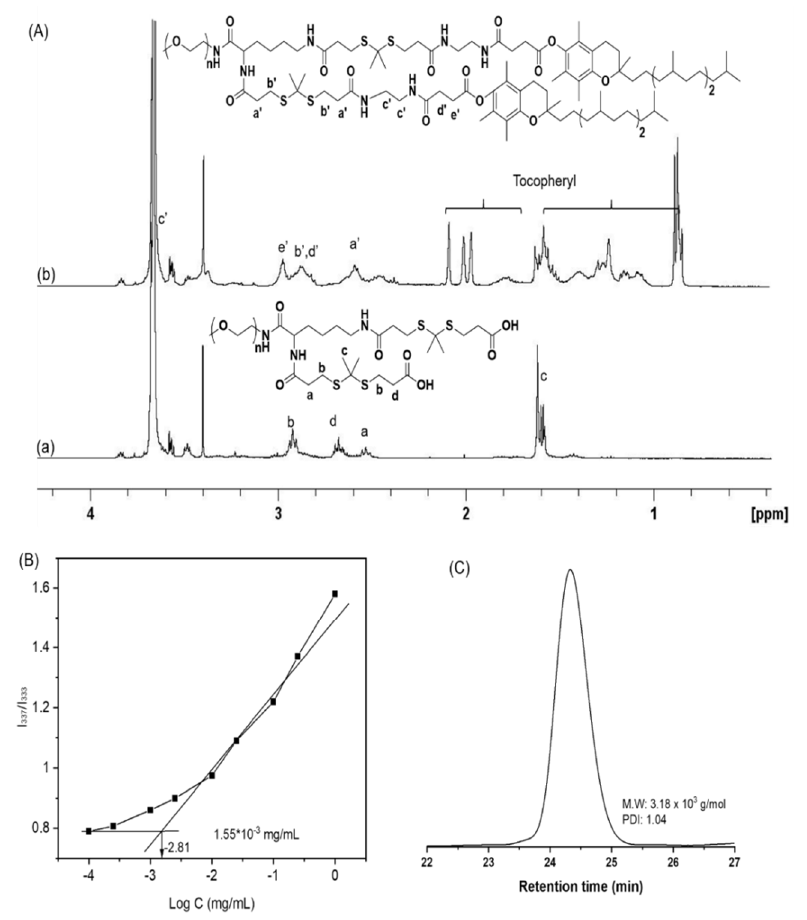
Figure 1. 1 H NMR spectra of dithioketal-linked polyethylene glycol (DTP) (a) and dithioketal-linked ditocopherol polyethylene glycol (DTTP) (b) in CDCl3 ( A ). Plot of intensity ratios I 337 /I 333 from pyrene excitation spectra vs. logarithm of DTTP concentration ( B ). GPC trace of DTTP ( C ).